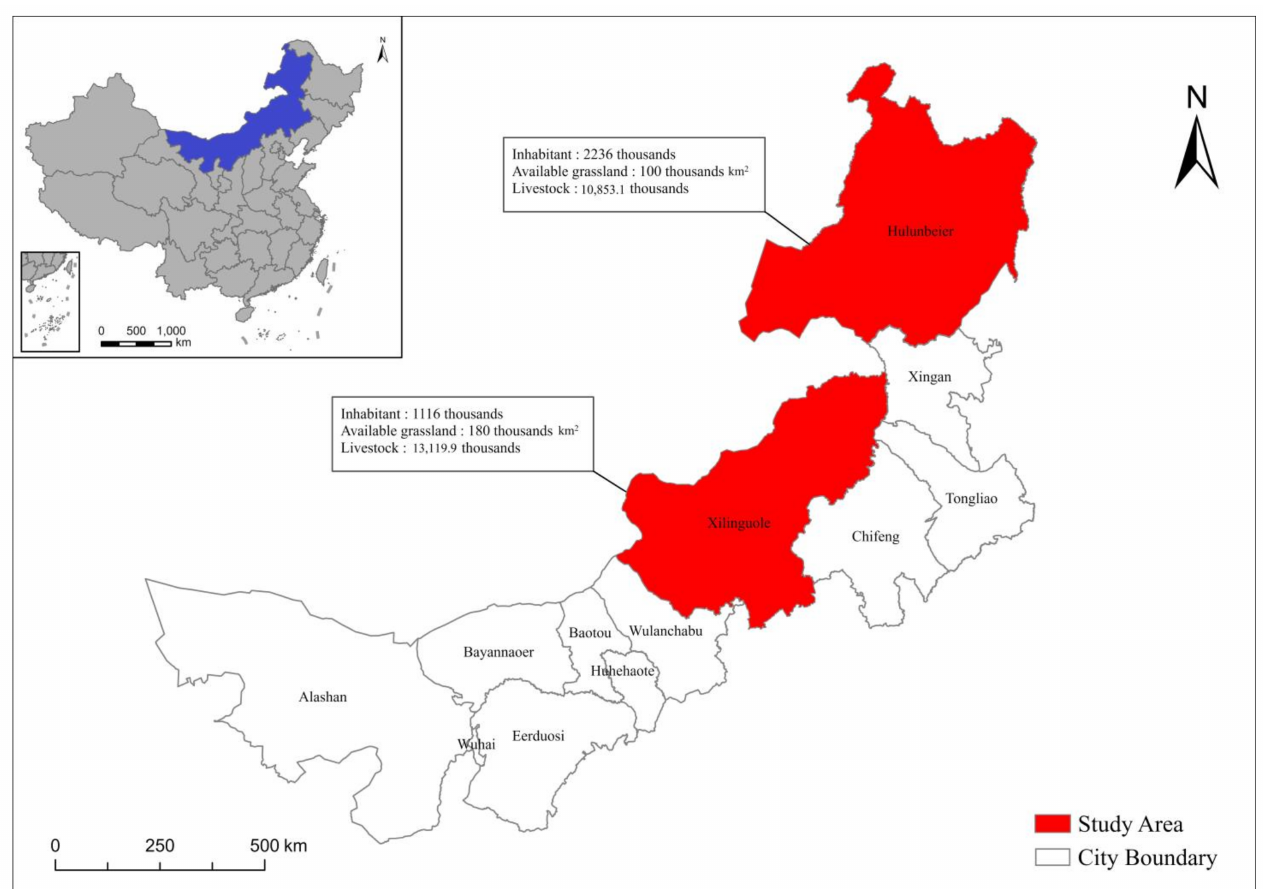
Figure 2. The study areas in Inner Mongolia.